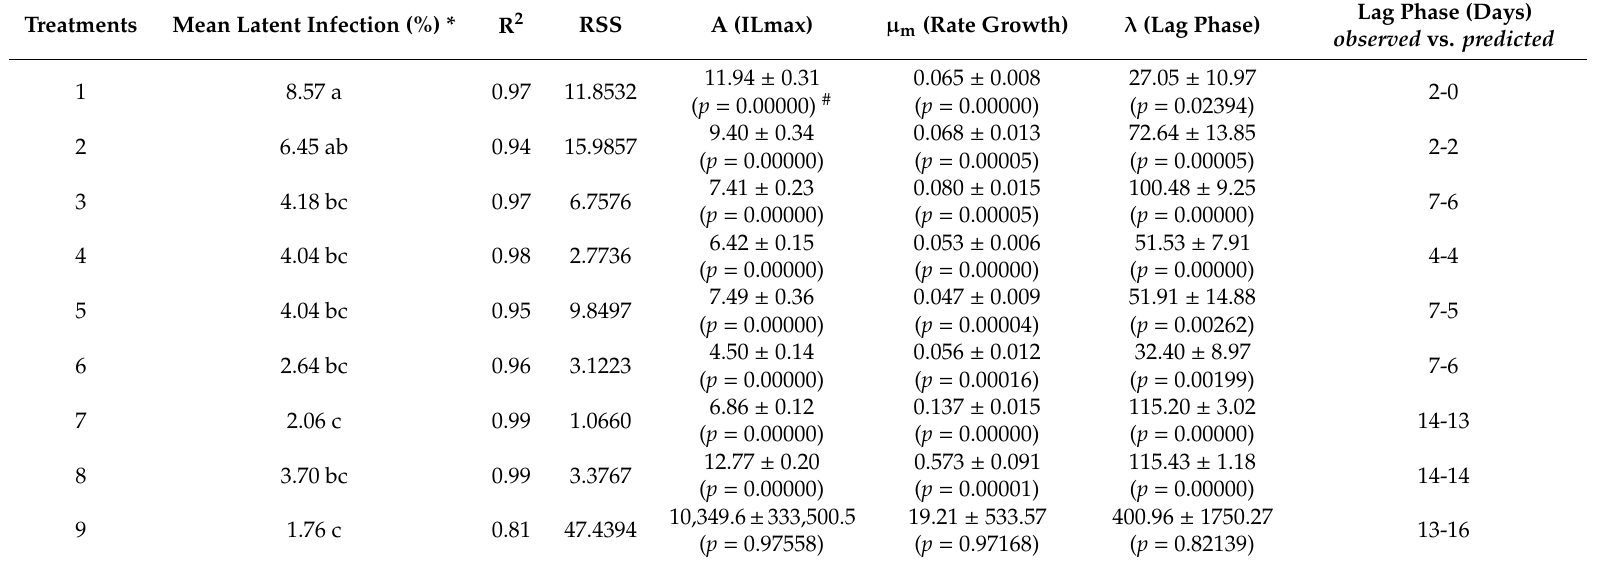
Table 5. Percentage of latent infection incidence from two cultivars at di ff erent postharvest handling treatments, coe ffi cient of determination (R 2 ), residual sum of squares (RSS), and parameters ± standard error (A is the maximum latent infection reached, µ m is the maximum growth rate, and λ is the lag phase duration before the beginning of latent infection growth) estimated for the modified Gompertz function describing the relationship between latent infection and degree-days above 0 ◦ C. C